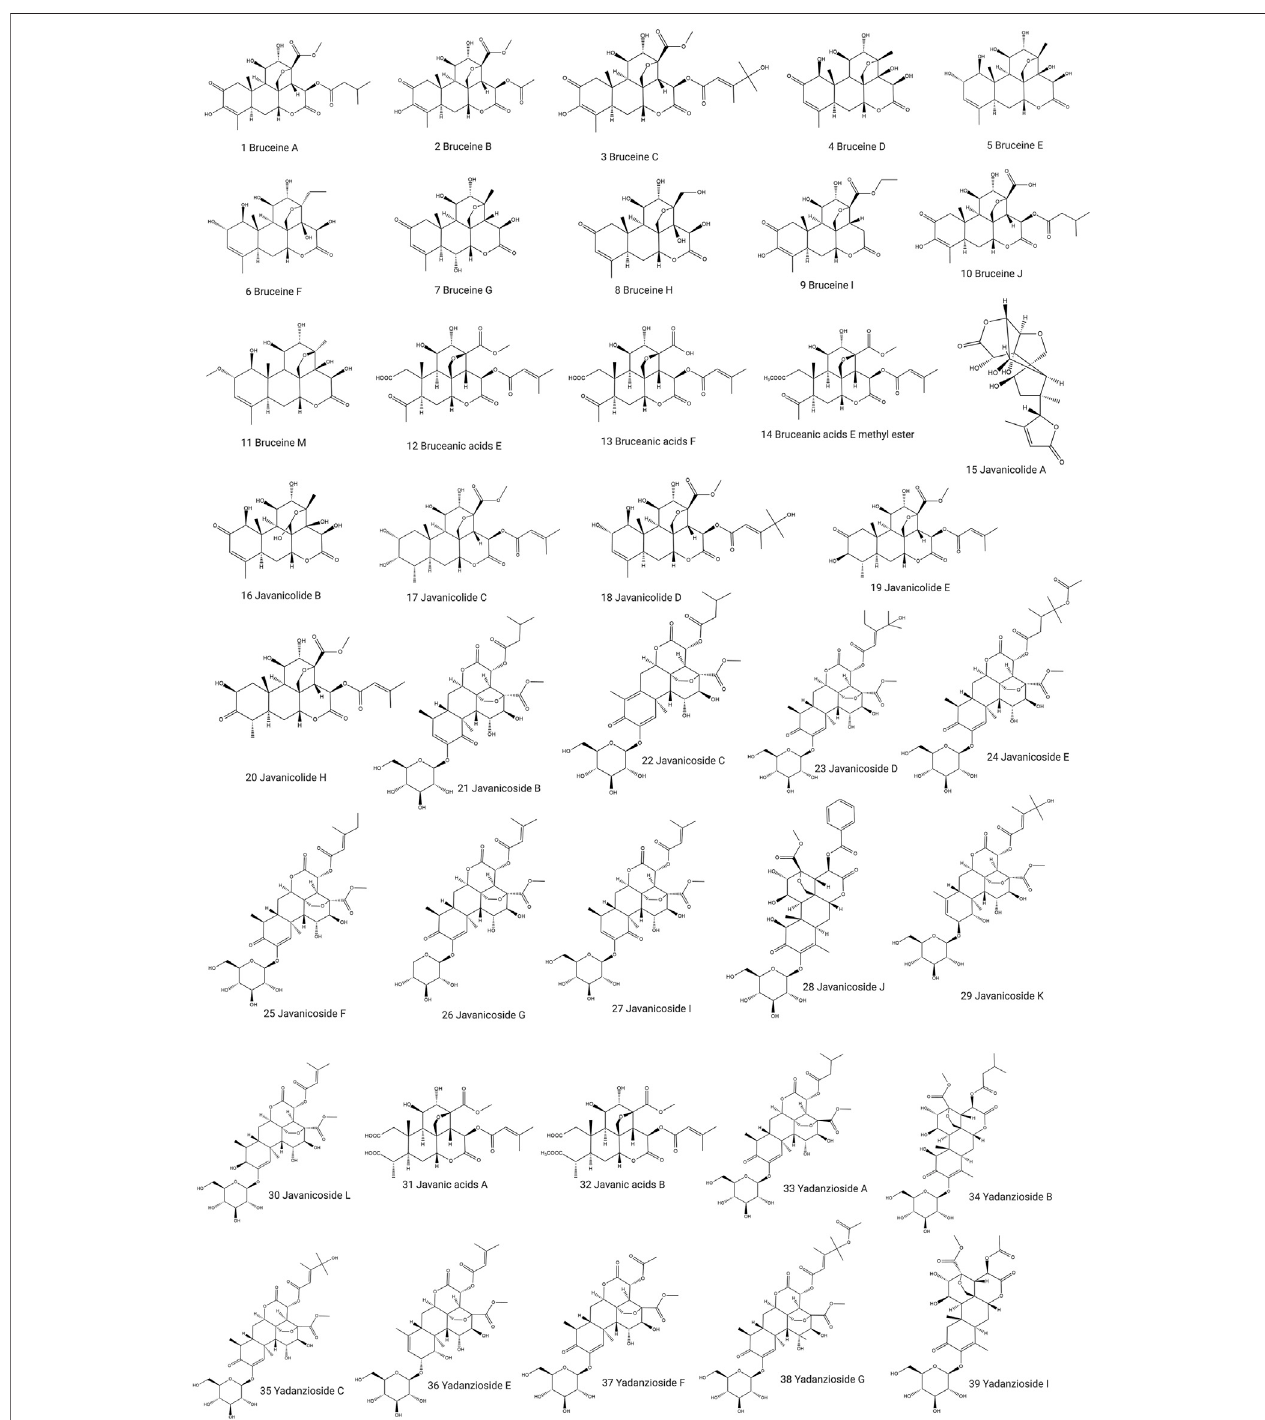
FIGURE 1 | Chemical structures of the compounds isolated from B. javanica .